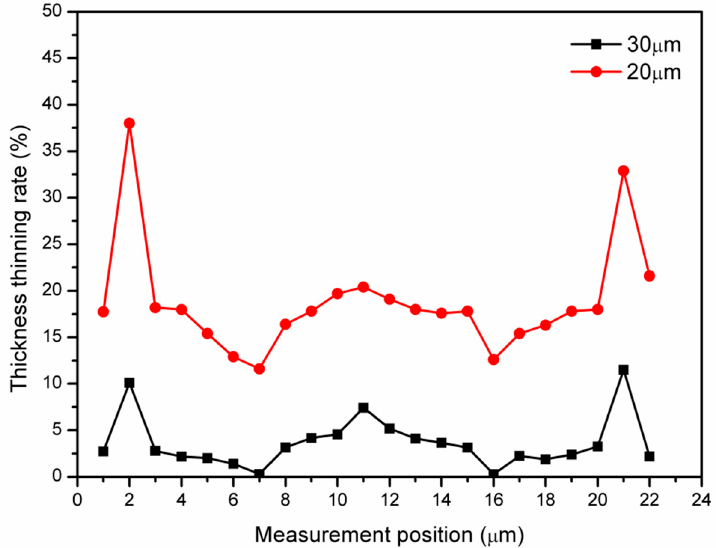
Figure 29. The thickness thinning rate distribution of the microchannel in the numerical simulation.